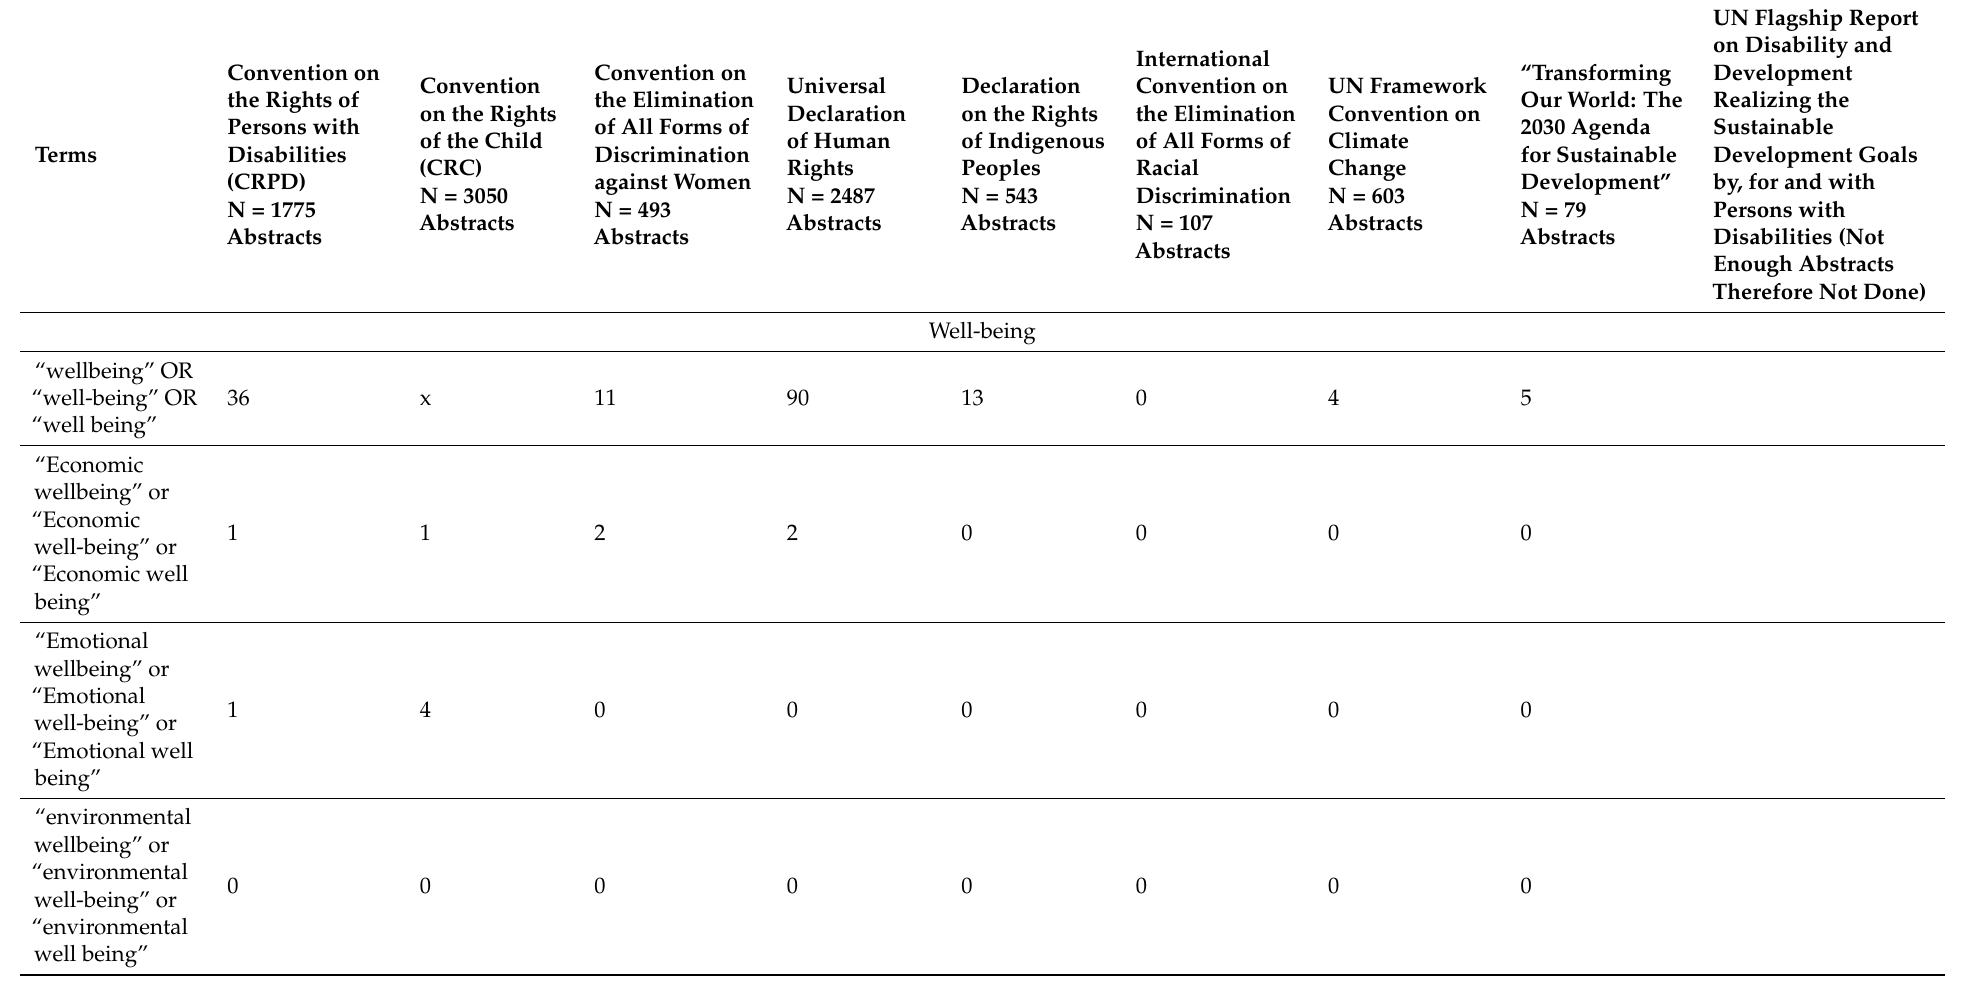
Table 9. hit counts for terms linked to the social from existing literature [10,11,103–141,173] in abstracts mentioning “the